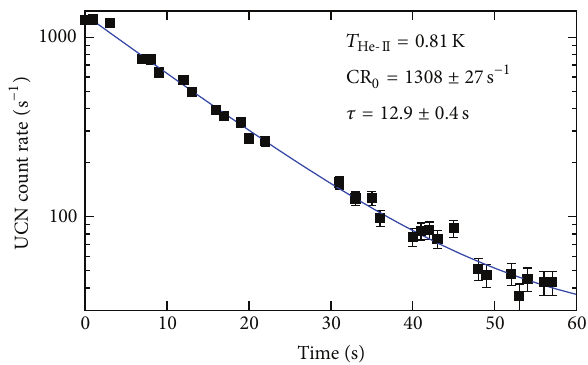
Figure11:EmptyingtimeofUCNsinthesourceandextractionwith Ti windows.